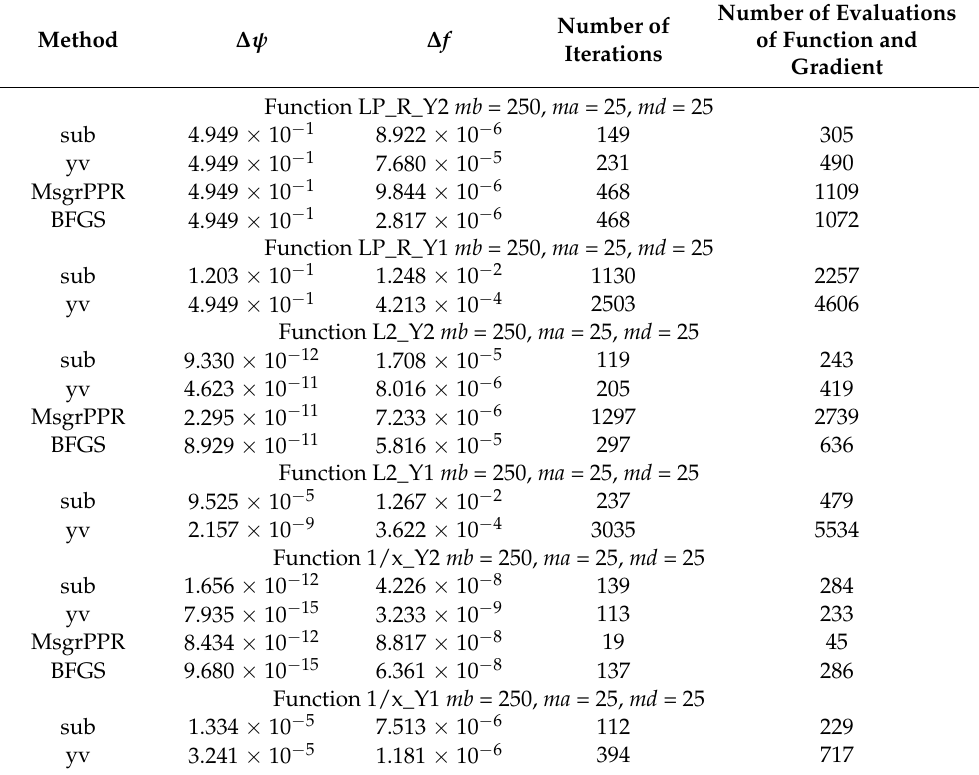
Table 6. Results of calculations for dimensions n = 10,000, m = 1000 with mb =